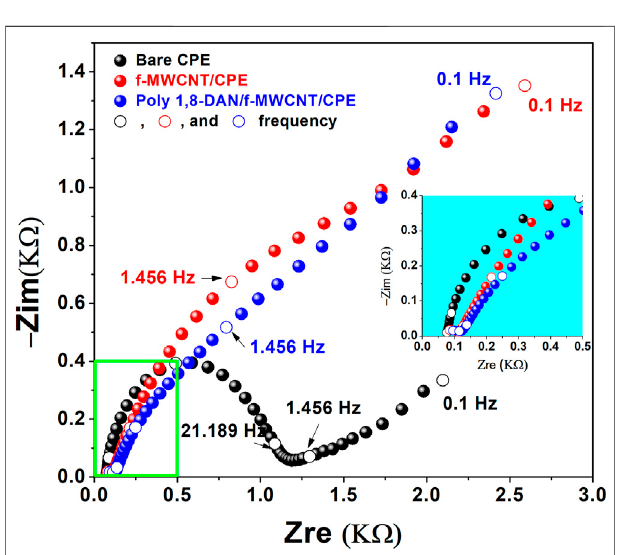
FIGURE 7 | Nyquist plots of CPE (black line), f-MWCNT/CPE (red line), and poly 1,8-DAN/f-MWCNT/CPE (blue line) in 0.1 M PBS containing 0.1 M KCl and 1 mM NO 2 − at pH 7.2 and a fi xed Potential of 0.85 V vs. Ag/AgCl.